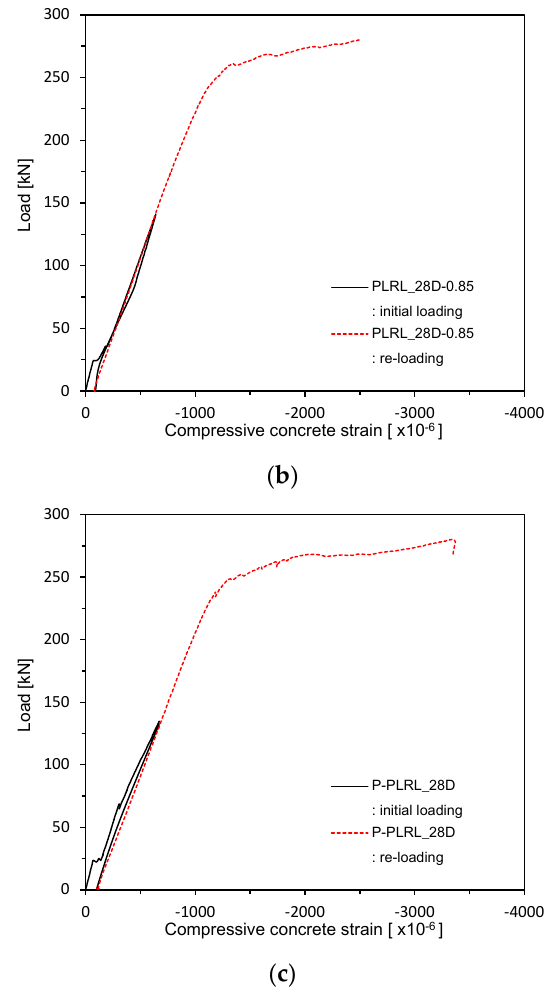
Figure 19. Load–concrete strain measurement after 28 days (up to ultimate load after pre-loading): ( a ) 2.5 series; ( b ) 0.85 series; ( c ) Plain series.